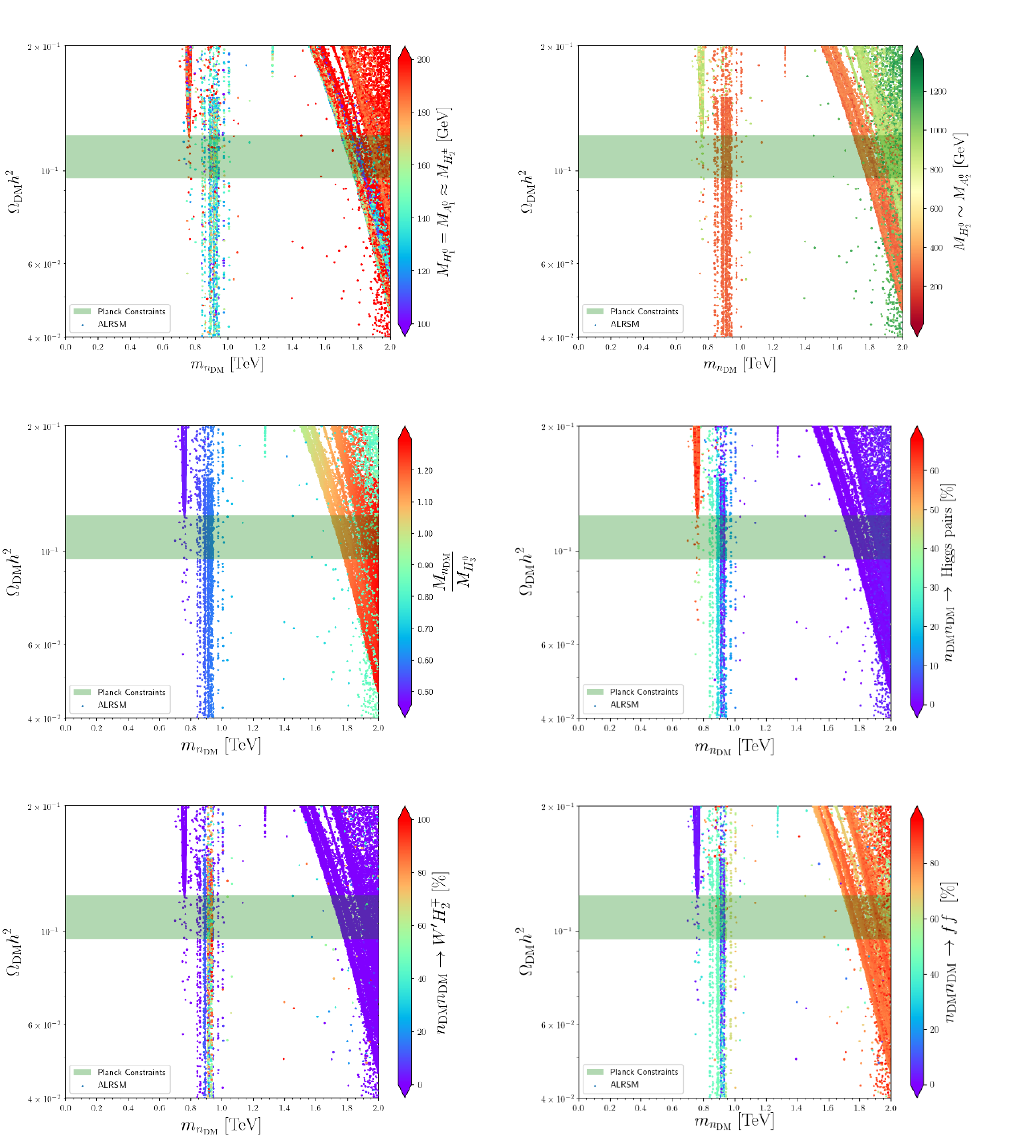
Figure 2 . Relic density predictions for all ALRSM scenarios satisfying the Higgs constraints imposed during our scan and compatible with LHC Z 0 bounds, and its dependence on the mass of the lightest scotino. In each panel of the (cid:12)gure, we depict a speci(cid:12)c property of all those scenarios. In the upper left panel, we represent by a colour code the mass of the H 0 , A 0 and H (cid:6) Higgs states, 1 1 2 whilst in the upper right panel, we focus on the one of the H 0 and A 0 Higgs bosons. The mass of 2 2 the scalar Higgs boson H 0 is presented relatively to the scotino mass in the central left panel, and 3 the fractions of the DM annihilation cross section associated with annihilations in Higgs bosons, W 0(cid:6) H (cid:7) systems and fermions pairs are given in the central right, lower left and lower right panels 2 respectively.